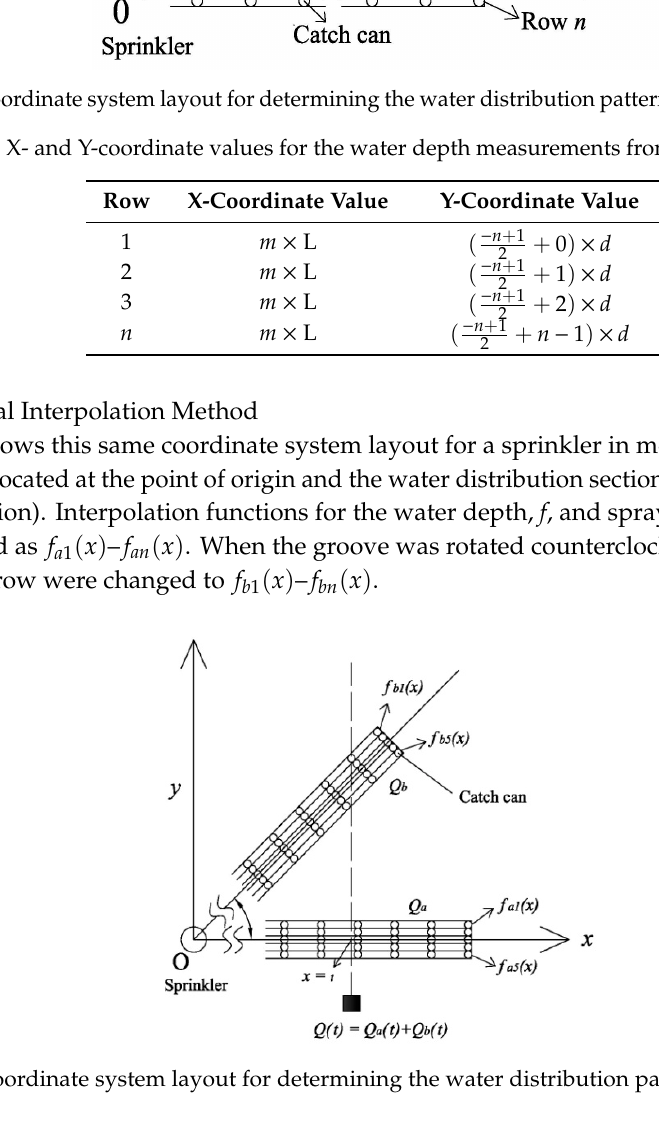
Figure 3. Coordinate system layout for determining the water distribution pattern from a sprinkler in motion.